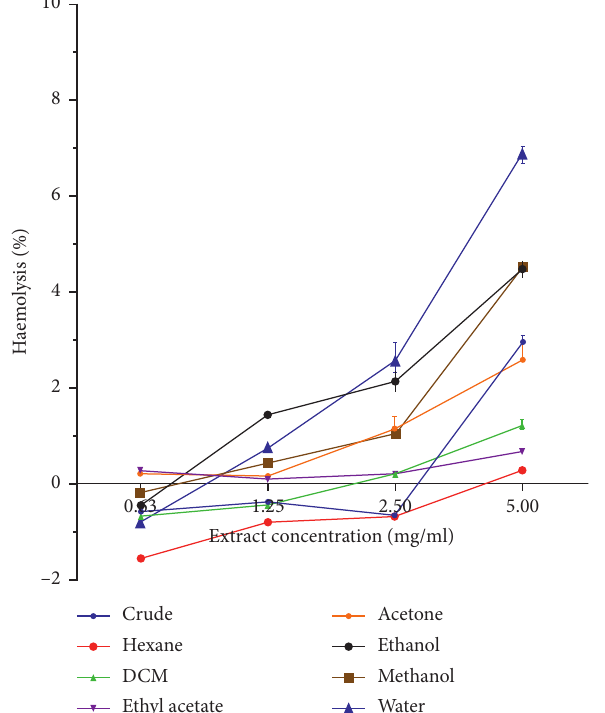
Figure 4: Comparison of the haemolytic activity of all serial exhaustive leaf extracts with respect to the crude extract. The water extract had the highest haemolytic activity. Crude is the DCM: methanol extract.